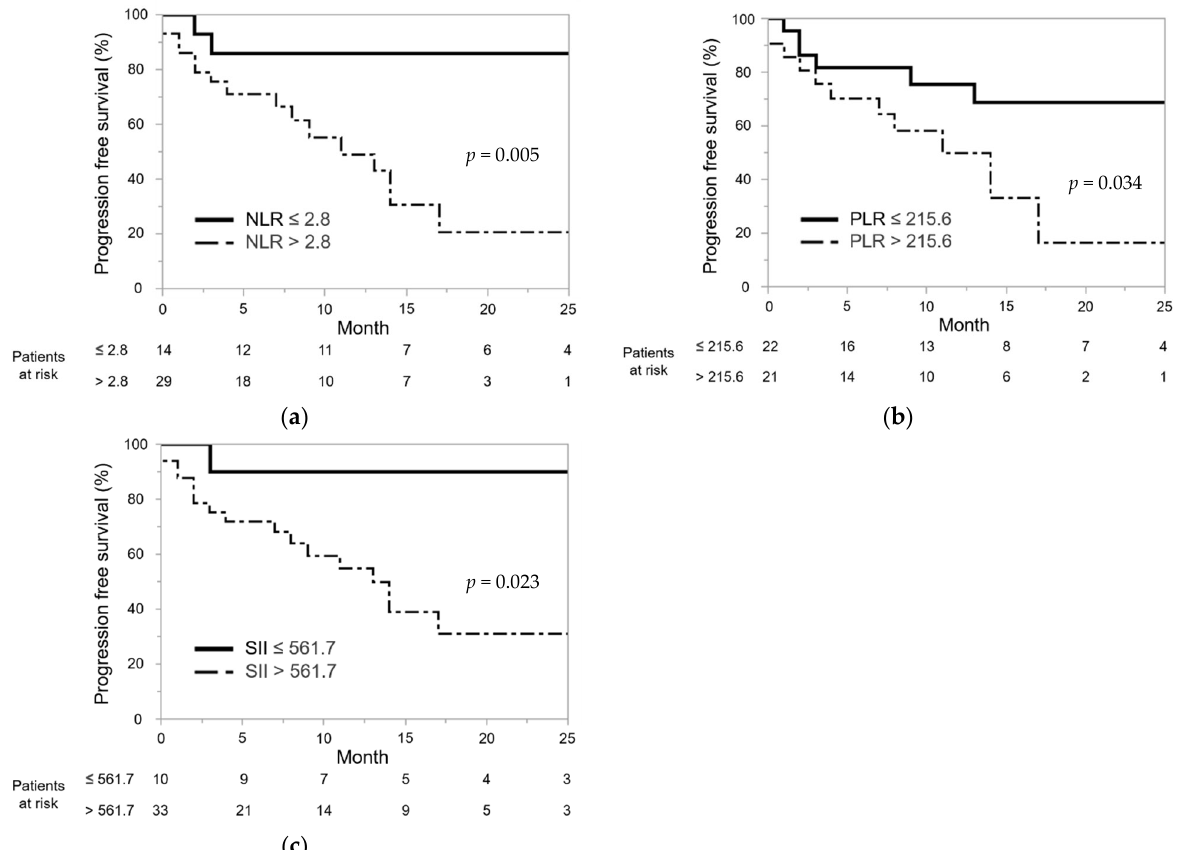
Figure 2. Kaplan ‐ Meier curves illustrating progression ‐ free survival (PFS): ( a ) per neutrophil ‐ to ‐ lymphocyte ratio (NLR) with a cutoff value of 2.8, ( b ) per platelet ‐ to ‐ lymphocyte ratio (PLR) with a cutoff value of 215.6, and ( c ) per systemic immune inflammation index (SII) with a cutoff value of 561.7. The 1 ‐ year PFS rates were 85.7% and 49.1% for NLR ≤ 2.8 and > 2.8, respectively ( p = 0.005; Figure 2a), and 75.5% and 49.7% for PLR ≤ 215.6 and > 215.6, respectively ( p = 0.034; Figure 2b). Regarding SII, the 1 ‐ year PFS rates were 90.0% and 54.8% when SII was ≤ 561.7 and >561.7, respectively ( p = 0.023; Figure 2c).